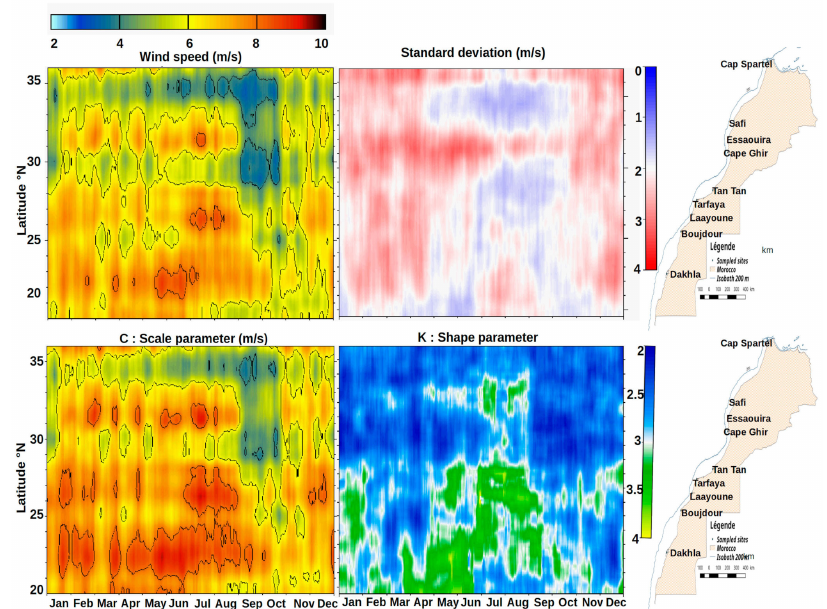
Figure 7. Weibull parameters, wind speed and the corresponding standard